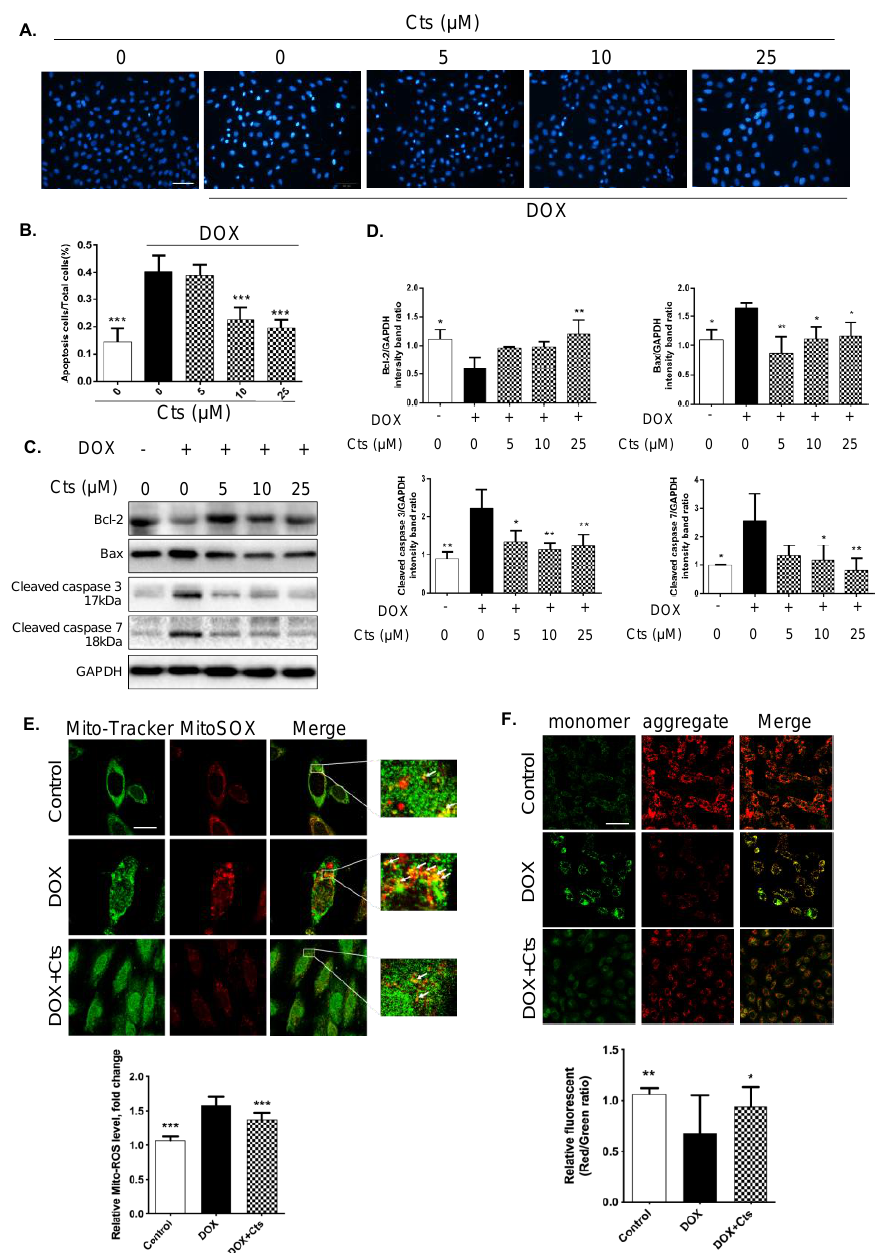
Figure 2. Effects of Cts on mitochondrial apoptosis. ( A ) The Hoechst 33342 staining showed that apoptosis increased in the Dox-treated group, whereas Cts protected cells against Dox-induced apoptosis. Scale bar, 20 μ m. ( B ) Fluorescence intensity of Hoechst staining was determined by image J software. Results were presented as means ± SD ( n = 3 repeated experiments, 15 cells per group). *** p < 0.001 vs. Dox-treatment group. Results showed that Dox increased the apoptotic rate by 40.4%. Cts at 10 μM and 25 μM significantly reduced apoptotic rates by 22.4% and 19.4%, respectively. ( C , D ) Cts regulated expressions of proteins involved in apoptosis, including Bcl-2, Bax, Cleaved caspase 3 and Cleaved caspase 7. ( E ) Representative images of Mito-tracker, MitoSOX and merged images of both. Quantification of yellow dots in merged images. Scale bar, 50 μ m. ( F ) Representative images of JC-1 aggregates, JC-1 monomers and merged images of both. Ratio of JC-1 aggregates to JC-1 monomers. Scale bar, 25 μ m. Results were presented as means ± SD from independent experiments performed in triplicate. * p < 0.05, ** p < 0.01 vs. Dox-treatment group.